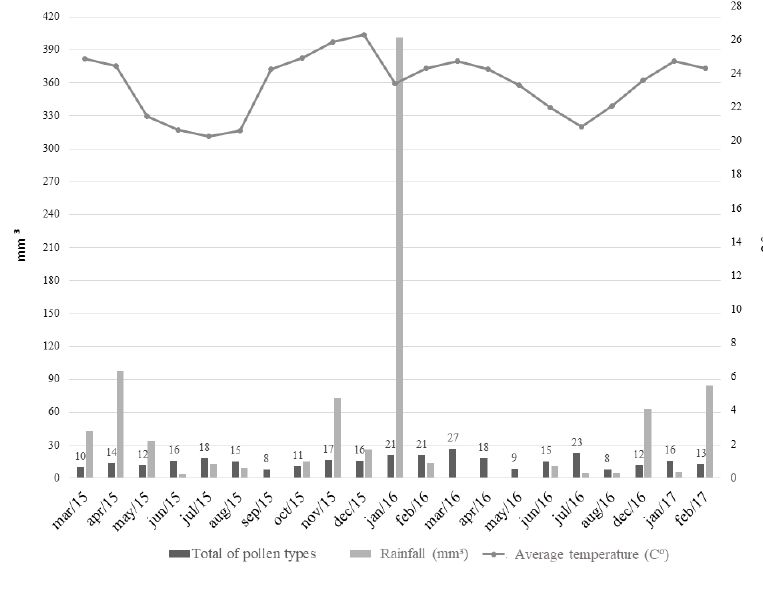
Figure 5. Monthly pollen diversity and climatic data of the study area (rainfall and